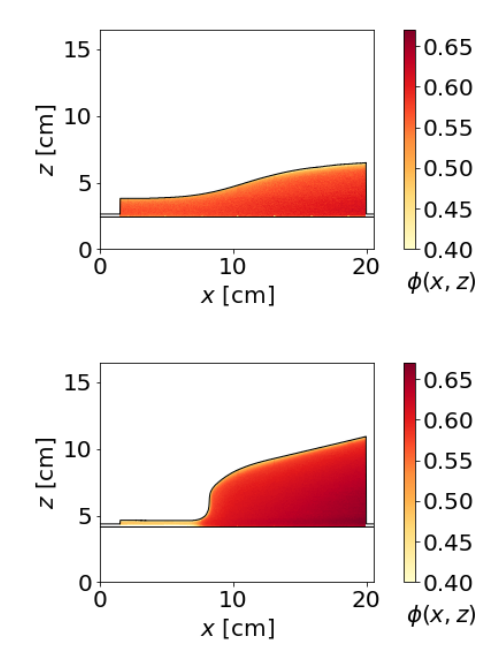
Figure 3. Examples of spatial distribution of the volume fraction φ ( x , z ) across the granular jumps, as measured by X-ray radiogra- phy for two di ff erent input conditions (glass beads): H / d = 29 . 1 and ζ = 25 ◦ (left panel) and H / d = 16 . 7 and ζ = 40 ◦ (right panel). The values of volume fraction are by construction aver- aged over the chute